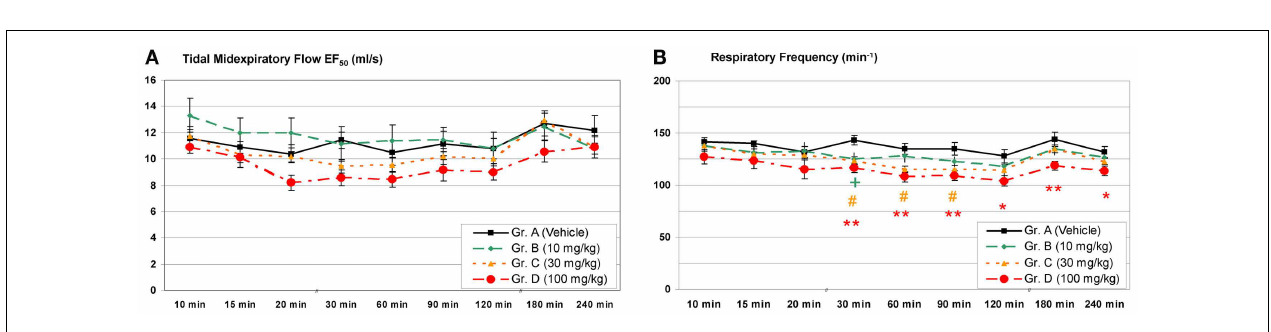
pharmacologically active test compound [mean ± SEM; + /#/ * = low/medium/high dose p < 0.05, ** = high dose p < 0.01 vs. control group; reprinted with permission from Hoymann